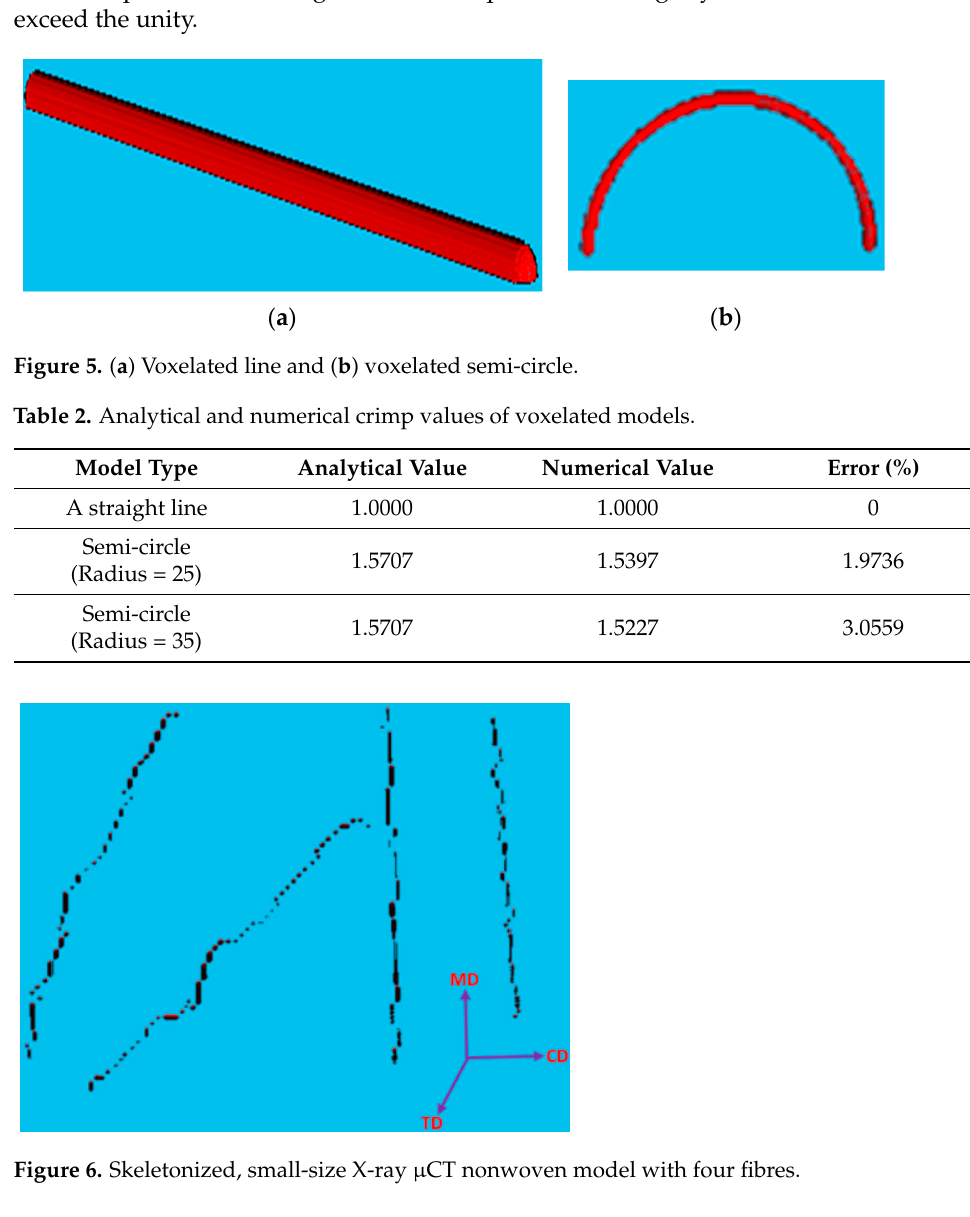
Table 3. Statistical data of small-size RFN.